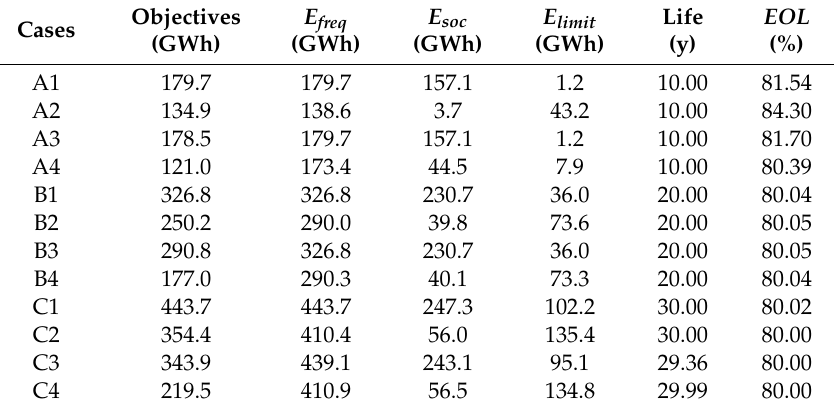
Table 6. Objective function, operating lifespan, and EOL for each